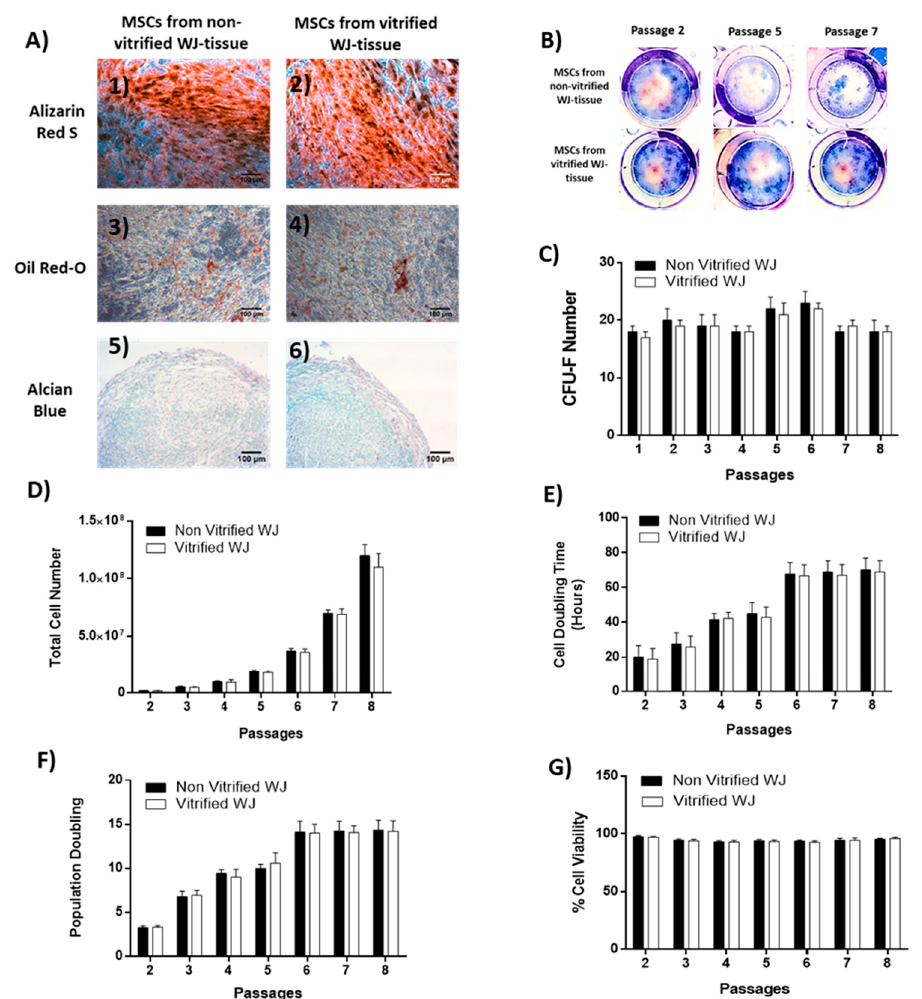
Figure 3. Characteristics of MSCs derived from non-vitrified and vitrified WJ tissue samples. ( A